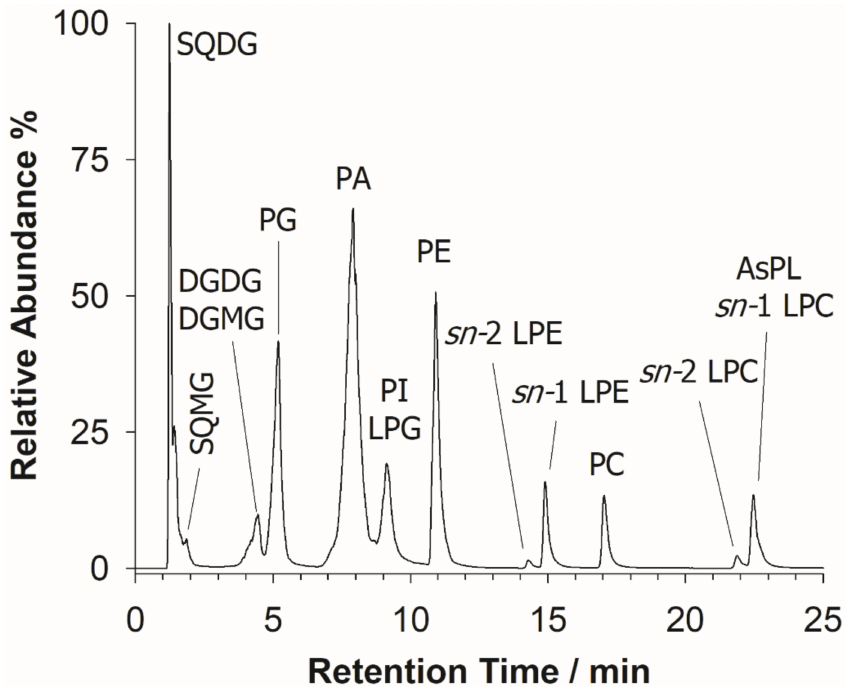
Figure 2. A typical total ion current (TIC) chromatogram arising from the HILIC-ESI(-)-FTMS full scan analysis of the BD extract of wakame seaweed. Sulfoquinovosyl diacylglycerols (SQDG), sulfoquinovosyl monoacylglycerols (SQMG), digalactosyl diacylglycerols (DGDG), digalactosyl monoacylglycerols (DGMG), phosphatidic acids (PA), phosphatidylinositols (PI), phosphatidylglyc- erols (PG), lyso-PG (LPG), phosphatidylethanolamines (PE), lyso-PE (LPE), phosphatidylcholines (PC), lyso-PC (LPC), and arsenosugar PL (AsPL) are labeled in the